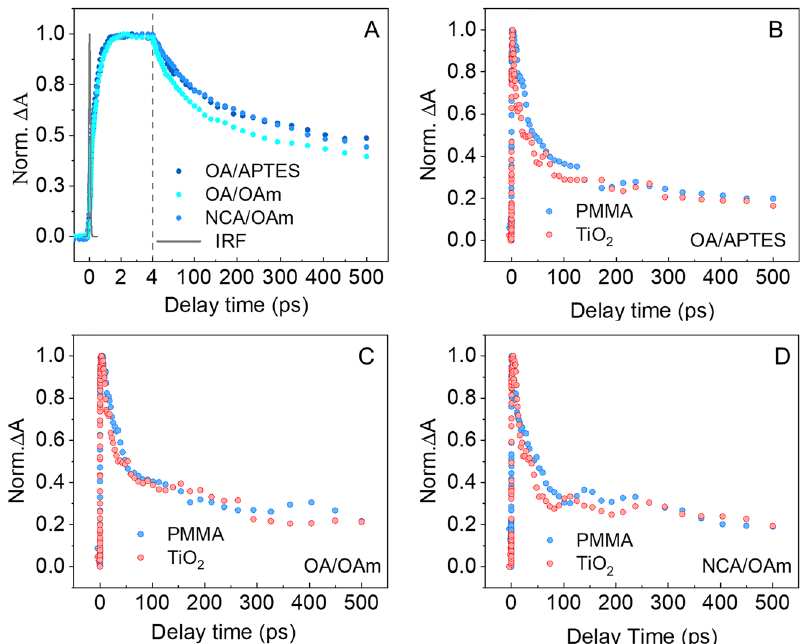
CsPbBr PeNC fi lms attached to PMMA and TiO 3 shows the normalized PB kinetic traces of CsPbBr